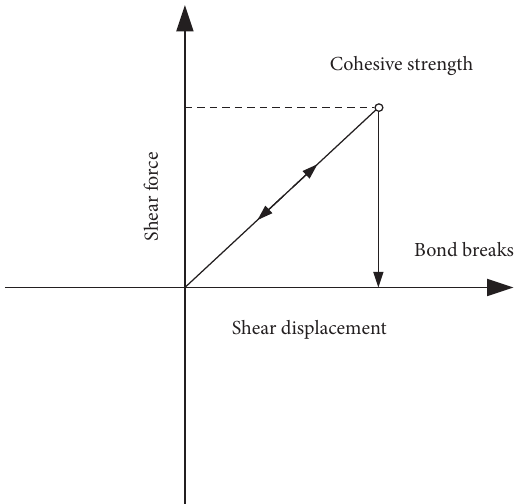
Figure 5: Shear force-shear displacement law of the